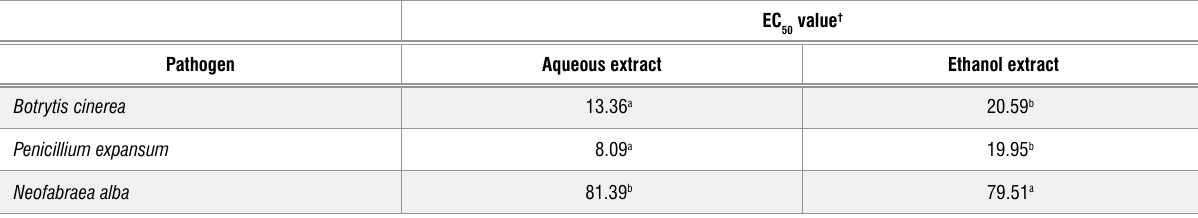
Table 2: The effective concentrations of aqueous and ethanol diluted garlic extracts that resulted in 50% inhibition (EC cinerea , Penicillium expansum and Neofabraea alba in vitro